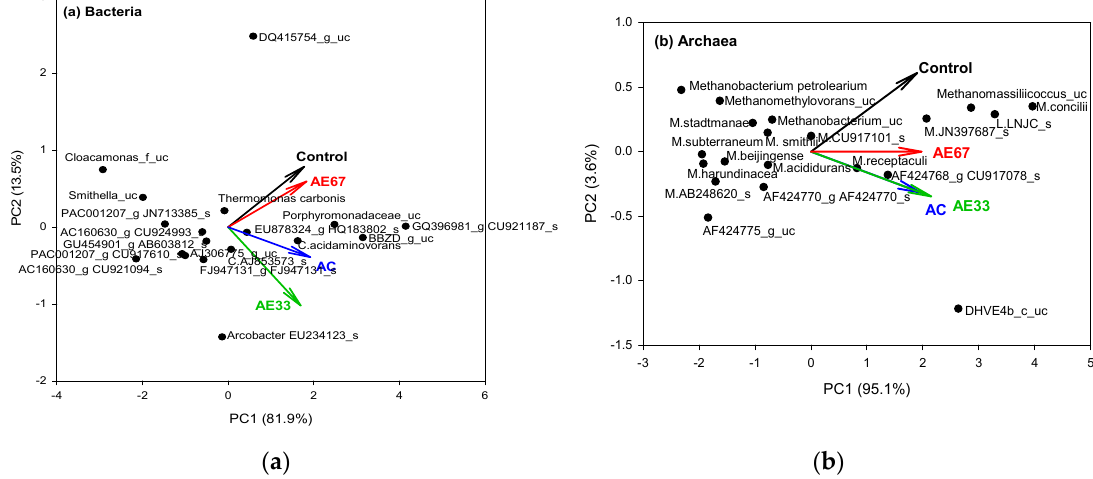
Figure 6. Biplot of the microbial species communities in the bulk solution: ( a ) bacteria and ( b ) archaea.